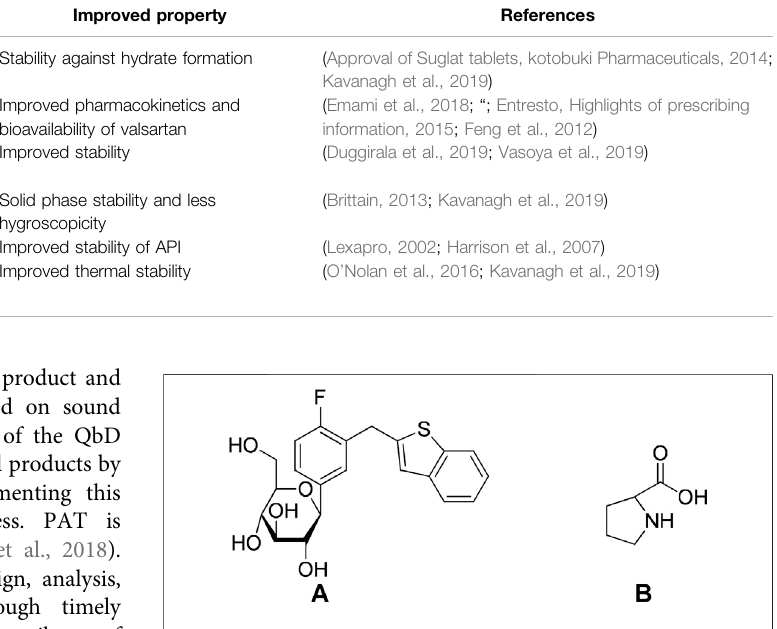
FIGURE 4 | Molecular structures of A. ipragli fl ozin (API) and B. L -proline